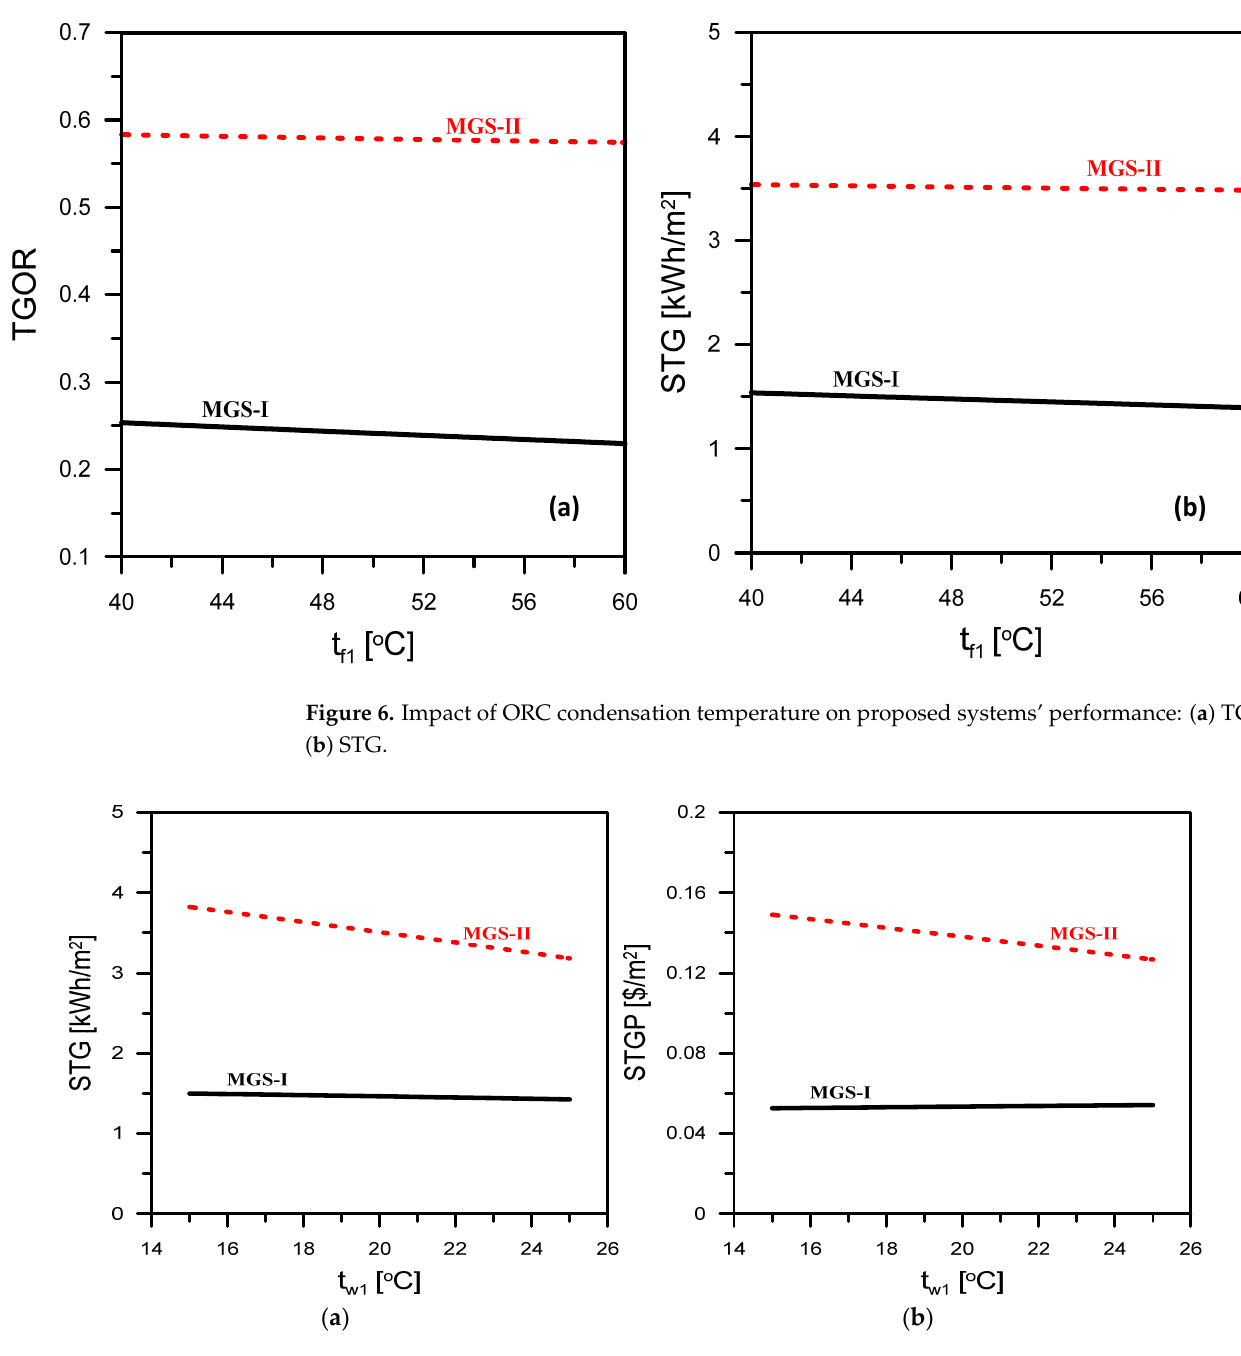
Figure 7. Impact of seawater inlet temperature on proposed systems’ performance: ( a ) STG; ( b ) STGP.